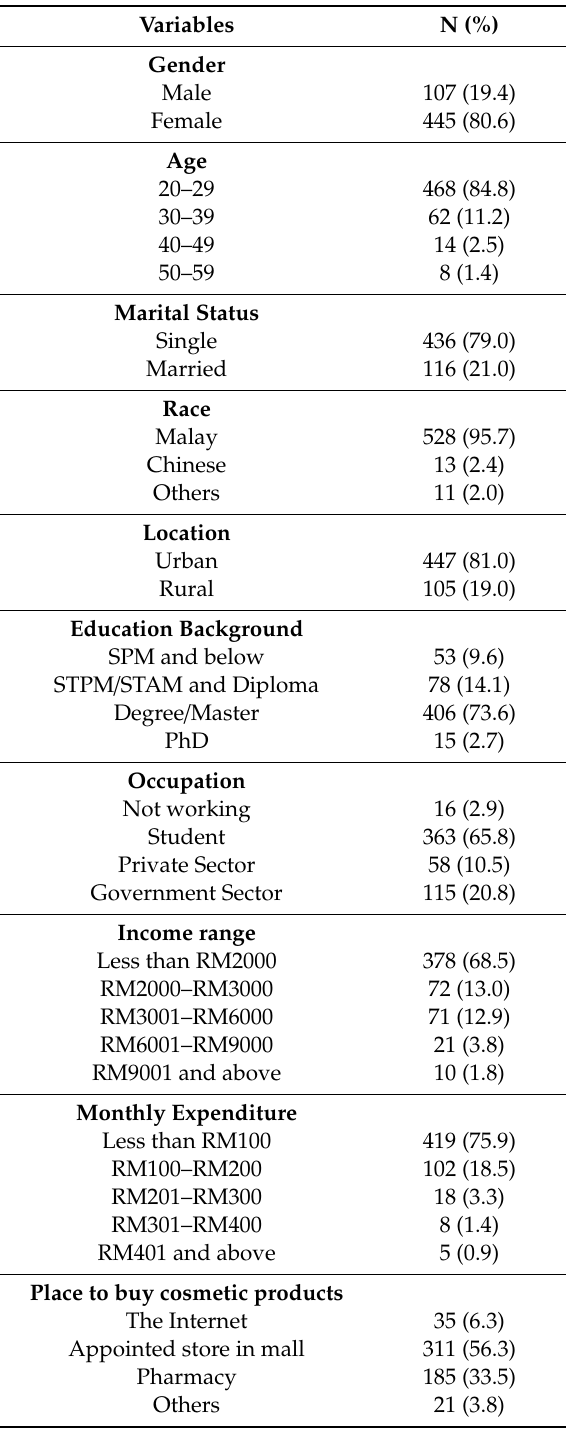
Table 1. Sociodemographic characteristics of